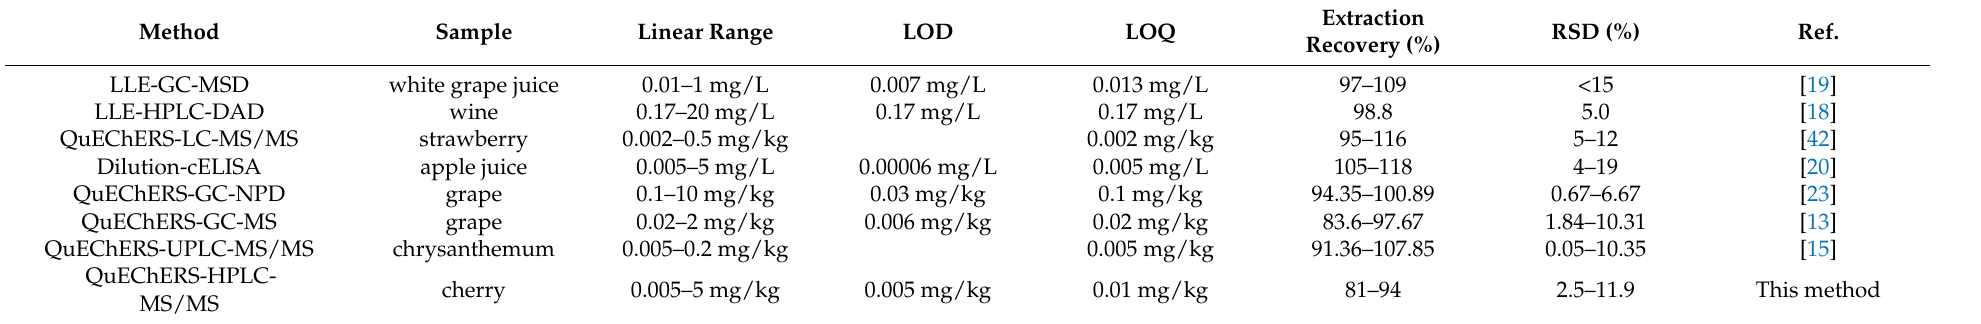
Table 3. Comparison of the presented method with other